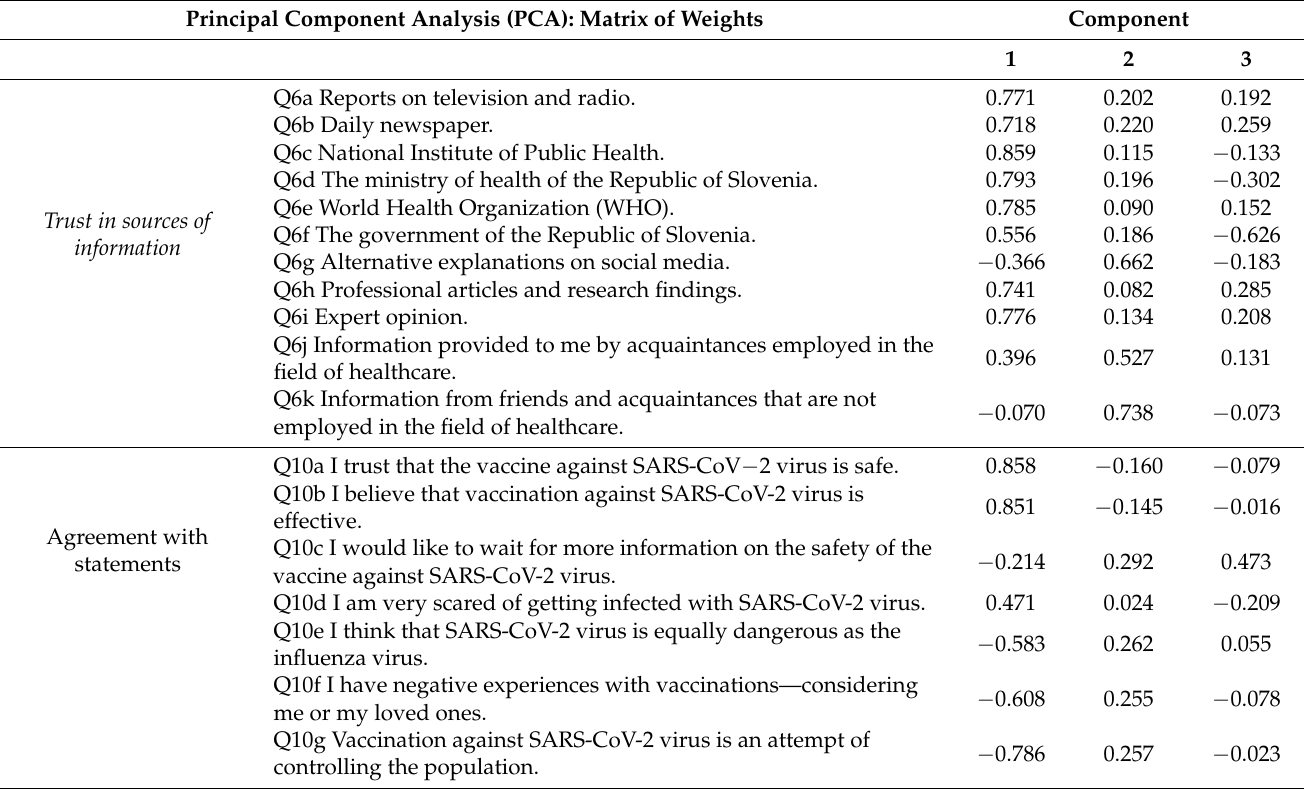
Table 2. Principal component analysis, a matrix of